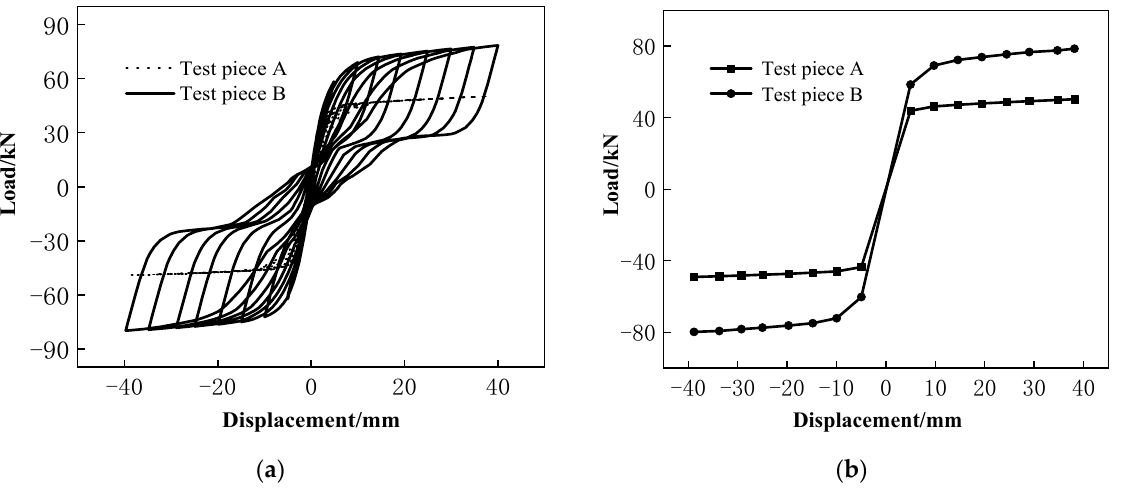
Figure 10. Comparison diagram of hysteretic characteristics. ( a ) Hysteretic curves of different piers. ( b ) Skeleton curves of different types of piers.